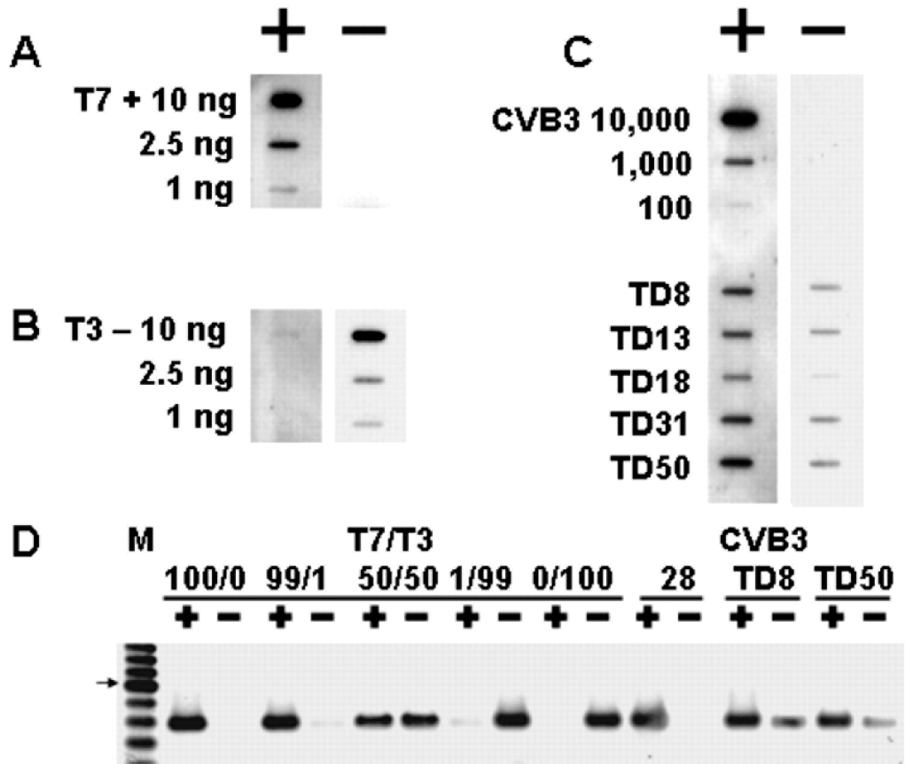
Figure 5. Positive and negative strands in wildtype and TD virions. ( A – C ) Slot blots of control and virion RNA detected with labeled strand-specific oligonucleotides. ( D ) Purified strands of control mixtures of strands or virion RNA amplified with RT-PCR and agarose electrophoresed. Reprinted with permission from [50], 2005, American Society for Microbiology.